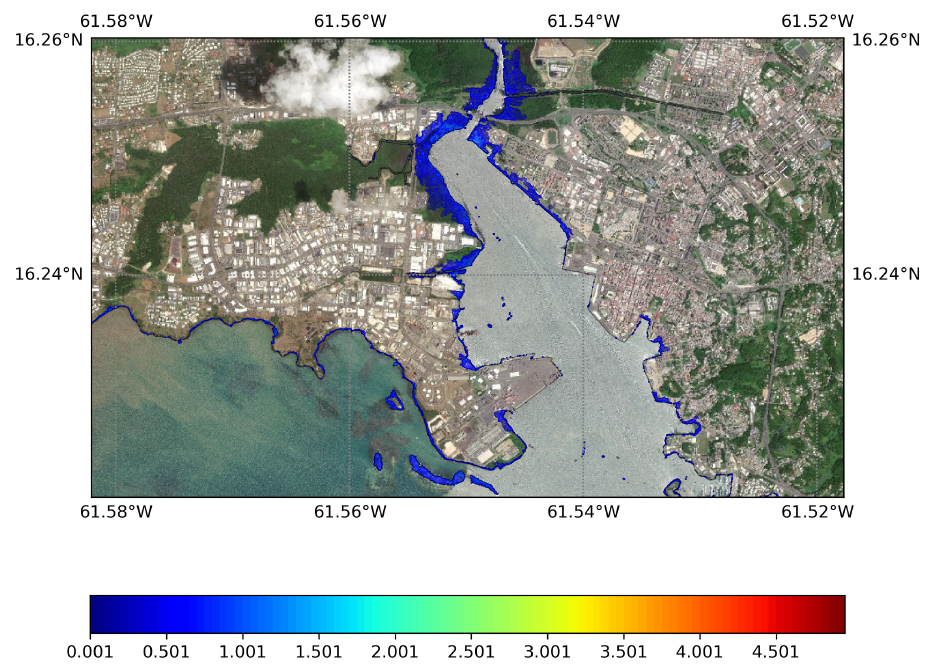
Figure 10. Maximum water depth for the Pointe-à-Pitre and Baie-Mahault region, Grande-Terre for the 80 km 3 scenario in the present